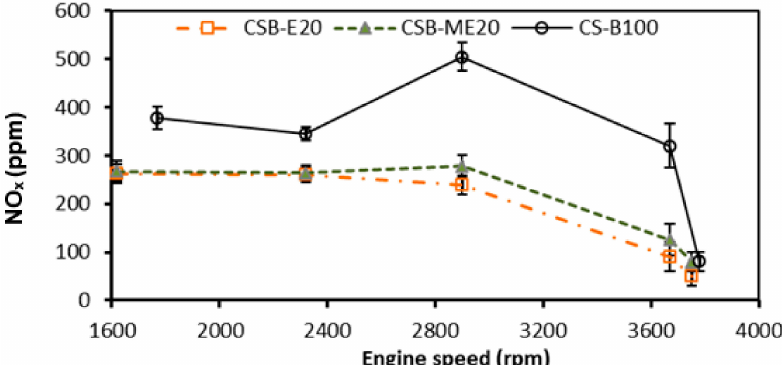
Figure 16. The relationship between engine speeds (rpm) and NO x (PPM) for CS-B100, CSB-E20 and